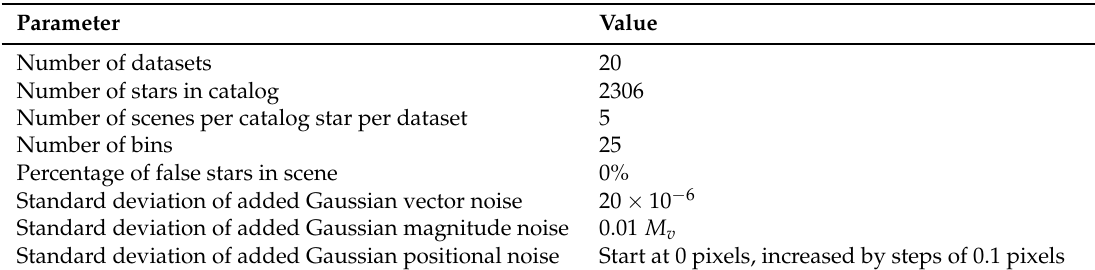
Table 3. Positional noise test dataset parameters.